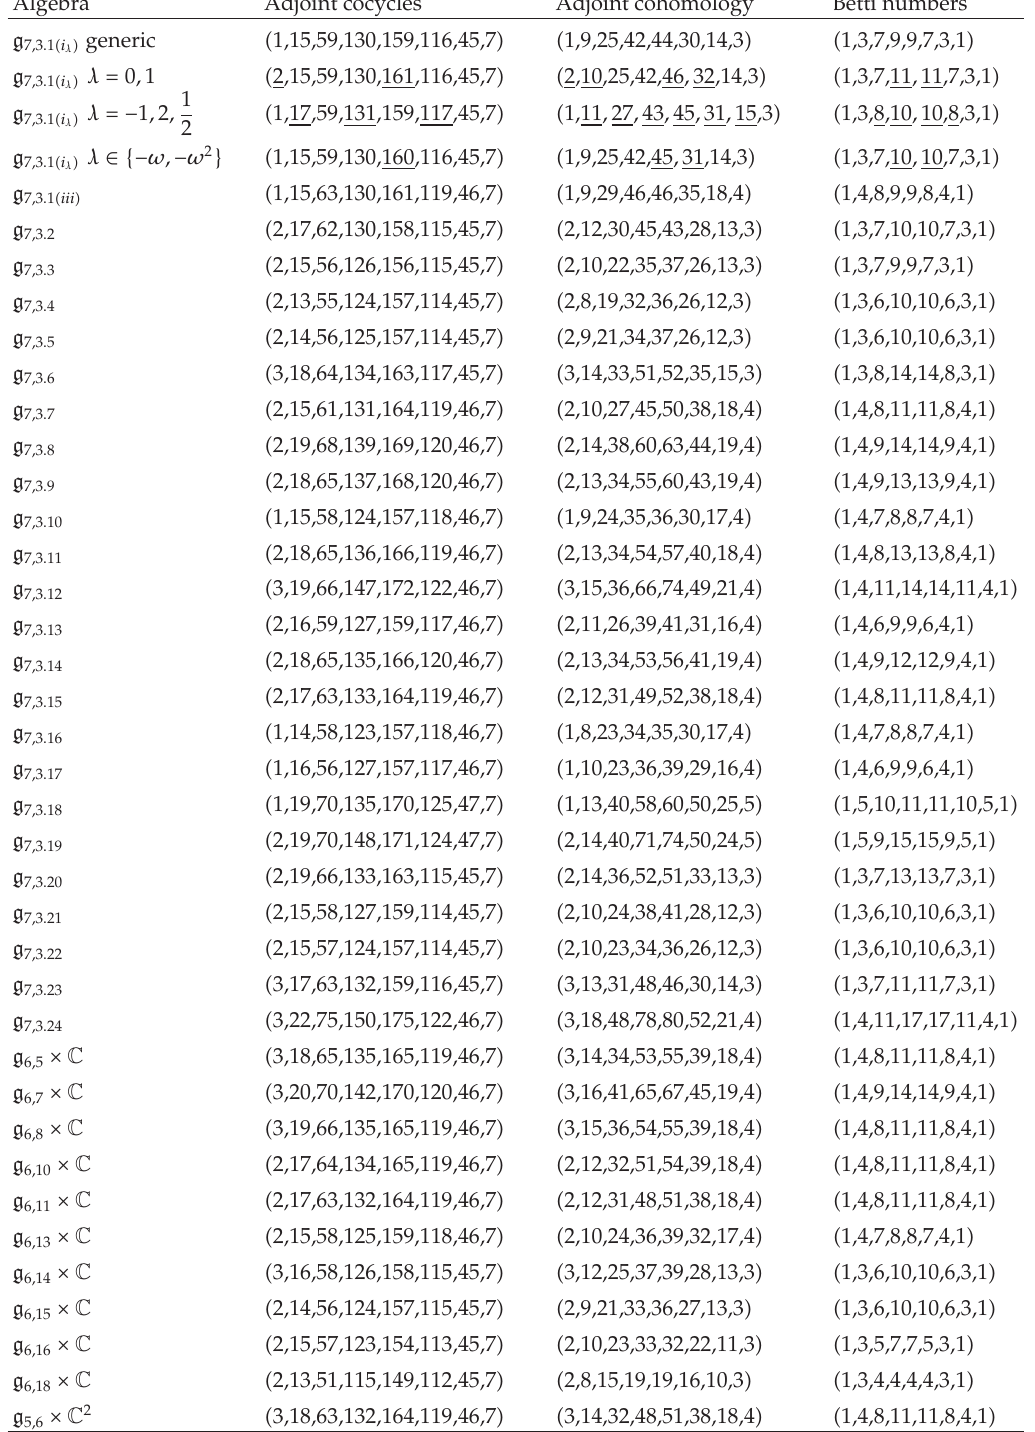
Table 6: Cohomology table for NLAs of dimension 7: rank 3. Algebra Adjoint cocycles Adjoint cohomology Betti